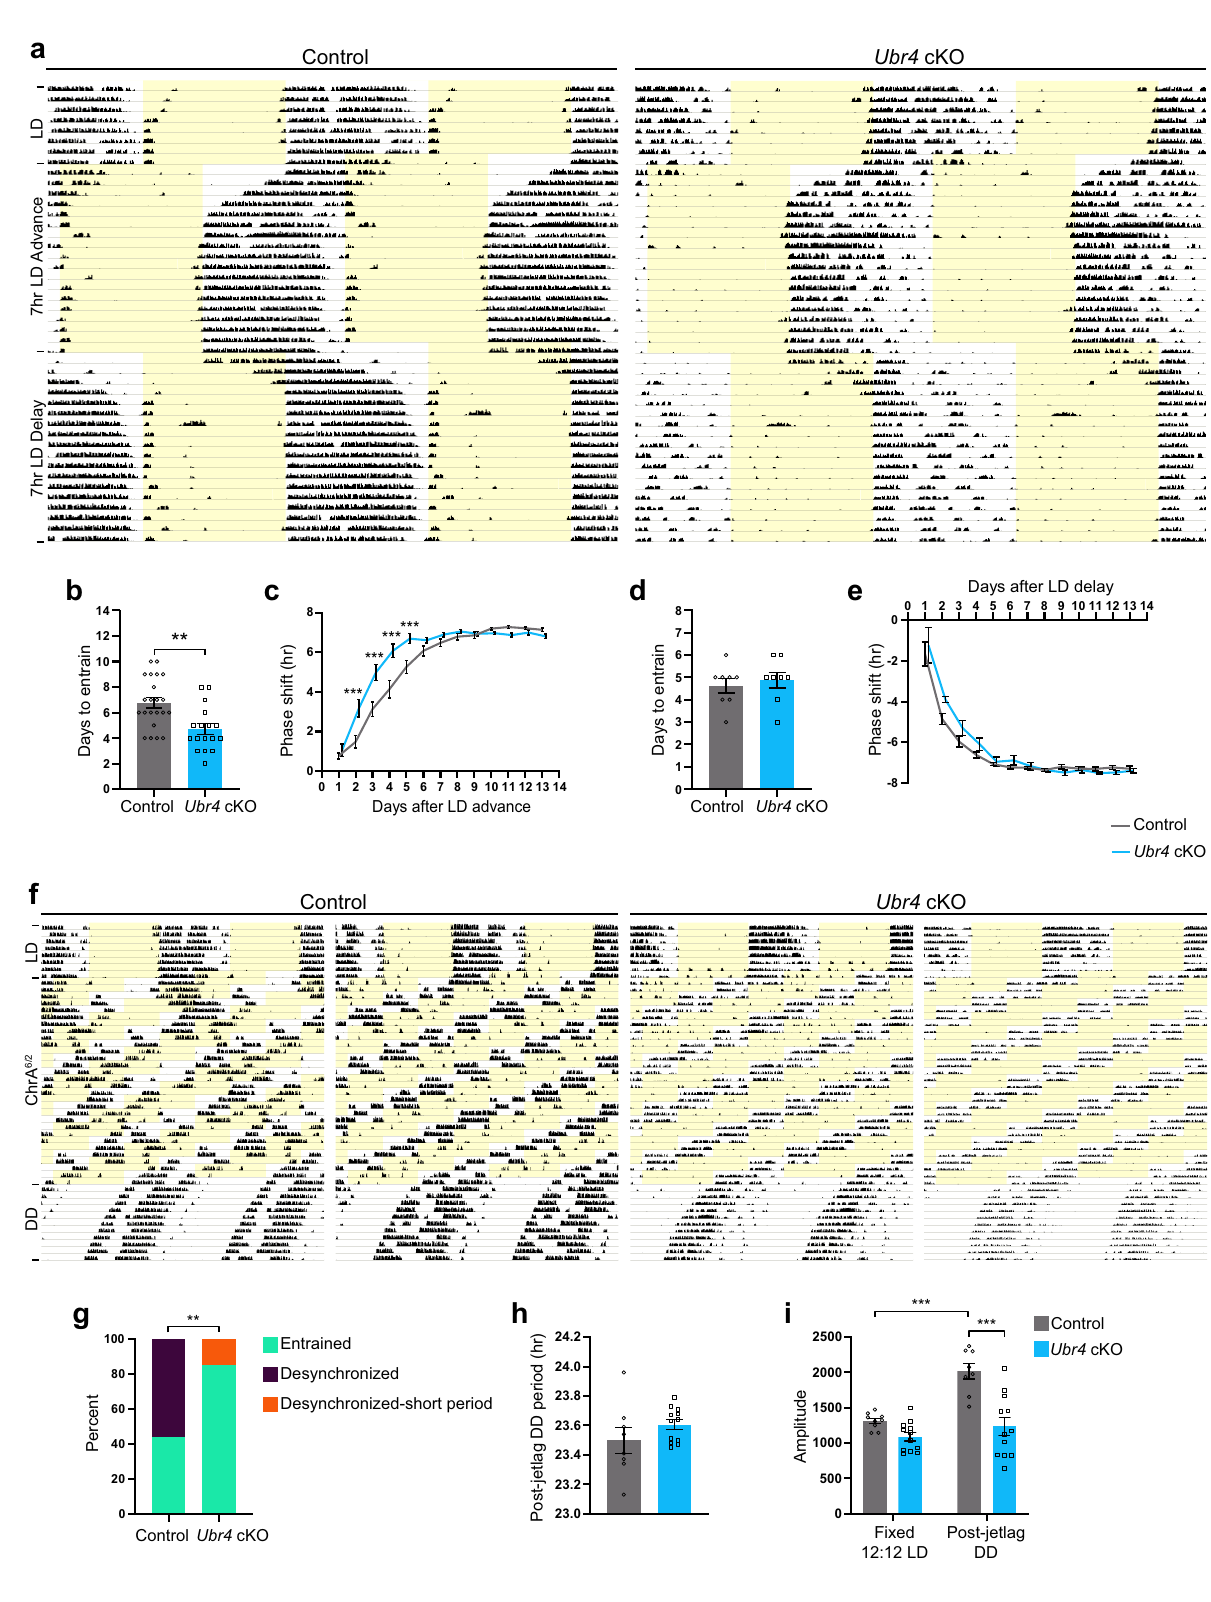
PDF-speci fi c poe knockdown alters PDF traf fi cking and damps dPER rhythms in fl y clock neurons . The behavioral phenotype of Pdf>Dcr2; poe RNAi fl ies under DD partially mimics that of Pdf - null ( Pdf 01 ) fl ies with respect to the delayed arrhythmicity 4 . Given the impaired axonal traf fi cking of VIP, the vertebrate func- tional homolog of PDF, in SCN neurons, we speculated that